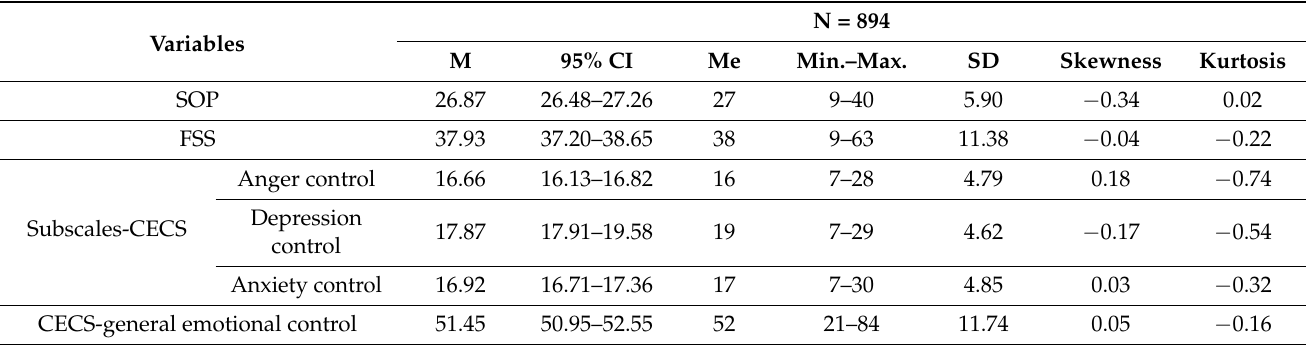
Table 1. Descriptive statistics of the variables under